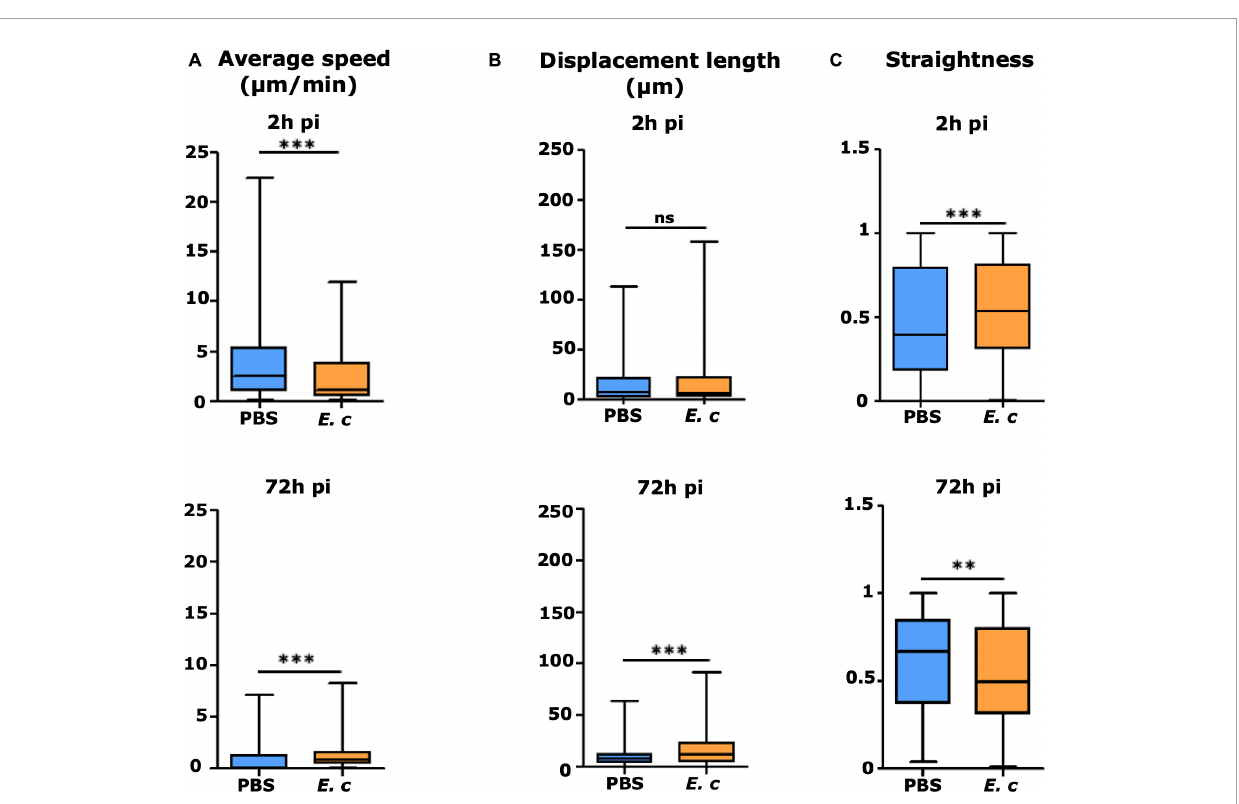
FIGURE5 Displacement properties of recruited EGFP + cells in the mouse ear pinna after inoculation of Encephalitozoon cuniculi spores. Average speed (A) , displacement length (B) , and straightness of trajectory (C) of EGFP + recruited cells to injection sites at early (2 h pi) and late (72 h pi) time points after inoculation of E. cuniculi spores or PBS (control) in the ear pinna tissue of LysM-EGFP mice. Data are expressed as median and interquartile ranges pooled from 2 ( E.c ) or 6 (PBS) different mice in 3 independent experiments. Number of cells (N) analyzed for each group at early and late time points, respectively, Control: N = 496 and 248 cells; Infected: N = 394 and 946 cells. Statistically significant difference compared to PBS control for the 3 displacement parameters with ∗∗ p < 0.005 and ∗∗∗ p <